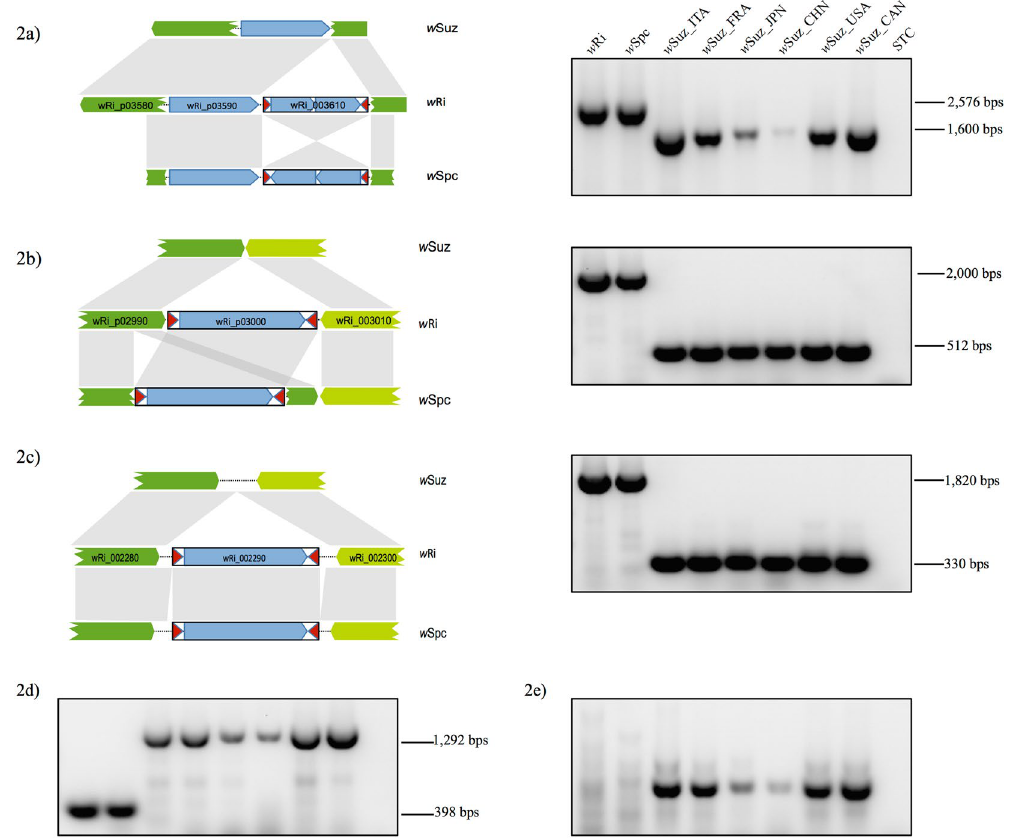
Figure 2. Inter-strain polymorphism between closely related wSuz, wSpc and wRi Wolbachia strains. Arrows with different shades of green represent different ORFs while the blue arrows represent transposase genes. Red arrowheads correspond to terminal inverted repeats (TIRs). A–C. w Ri-specific IS loci ( a ) IS element present at locus IS1 belonging to ISWpi1 group shows inversion between w Ri and w Spc, and absence from w Suz strain, ( b ) and ( c ) Two IS elements (loci ID- IS14 and IS22) show independent insertion events between w Ri and w Spc however completely absent from w Suz genome. ( d ) w Suz-specific IS element (locus ID- IS31) belonging to ISWpi1 group shows insertion only in w Suz from all populations producing 1292 bps long amplicon, but absent from w Ri and w Spc with 398 bps amplicon size. ( e ) Genomic rearrangement (GR1) showing amplification in w Suz only, absent in w Ri and w Spc. Lanes from left: w Ri, w Spc, w Suz_ITA, w Suz_FRA, w Suz_JPN, w Suz_CHN, w Suz_USA, w Suz_CAN and STC- Wolbachia negative control. The full-length gel pictures are presented in Supplementary Figure